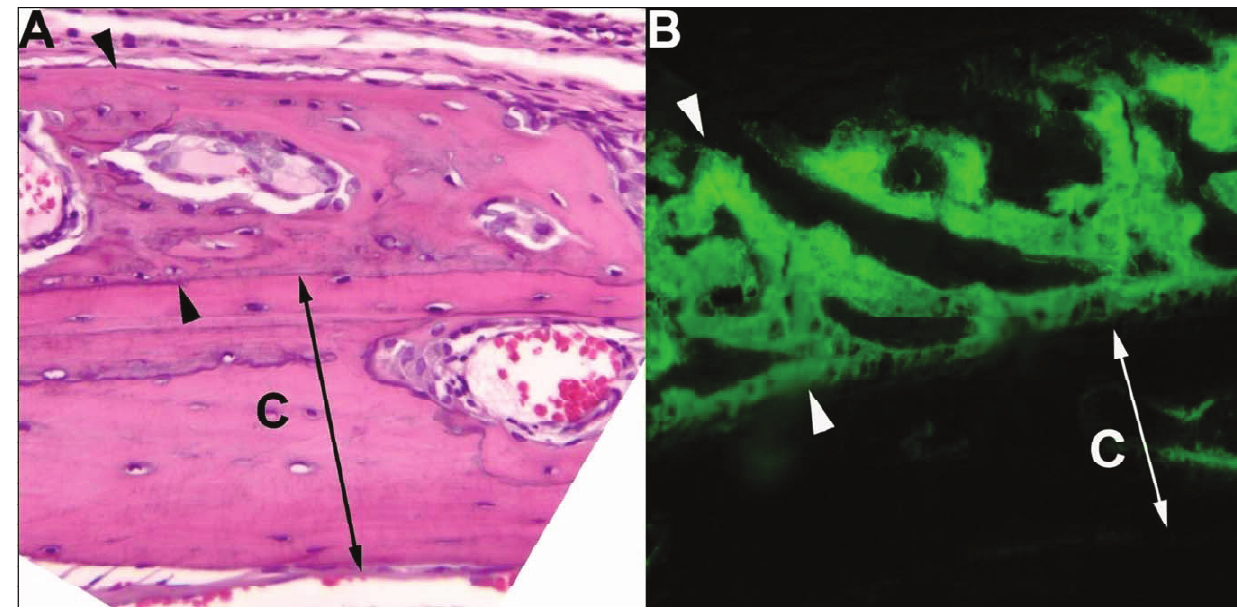
Figure 2. Effects of canine prostatic tissue implanted adjacent to murine calvaria in vivo. ( A ) Decalcified calvarium with prostate tissue implanted between the skin and calvarium (above and out of the plane of the image). Note pre-existing calvaria ( C ) and marked periosteal thickening caused by dramatic new bone formation (arrowheads) (H&E). ( B ) Undecalcified calcein-labeled prostate-implanted calvaria. Calcein is a green fluorescent calcium-binding dye that is taken up at sites of active bone mineralization. Note calcein fluorescence in mineralized periosteal new bone (arrowheads). Pre-existing calvaria ( C ) had minimal fluorescence (Unstained).